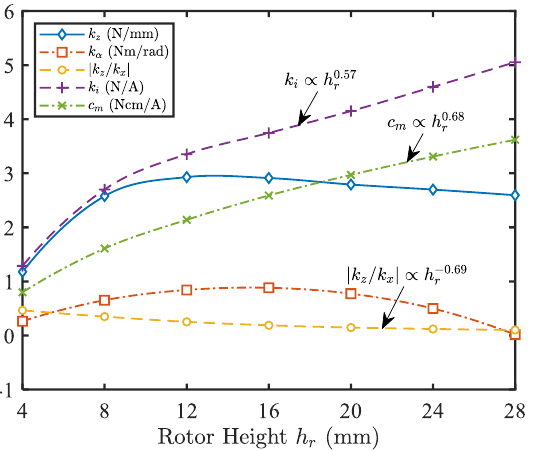
Figure 9. Motor properties under different rotor heights h r . The rotor diameter is 29